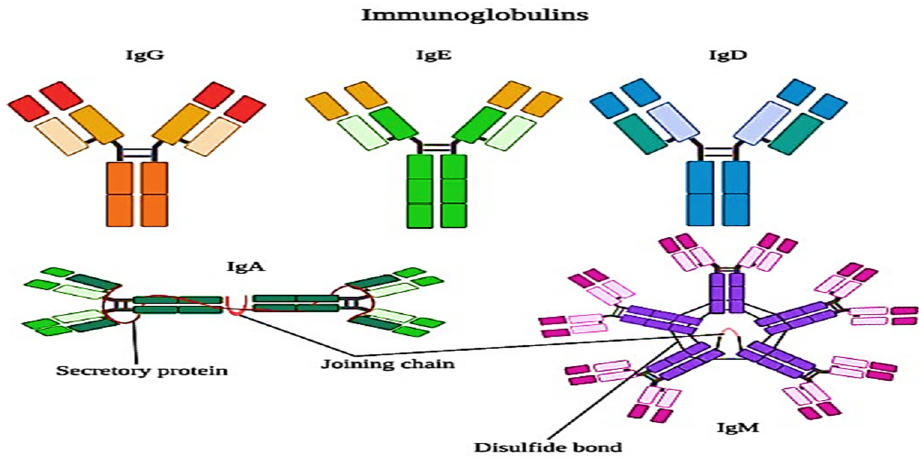
Figure 4. The polymeric structure of different types of immunoglobulins present in milk.